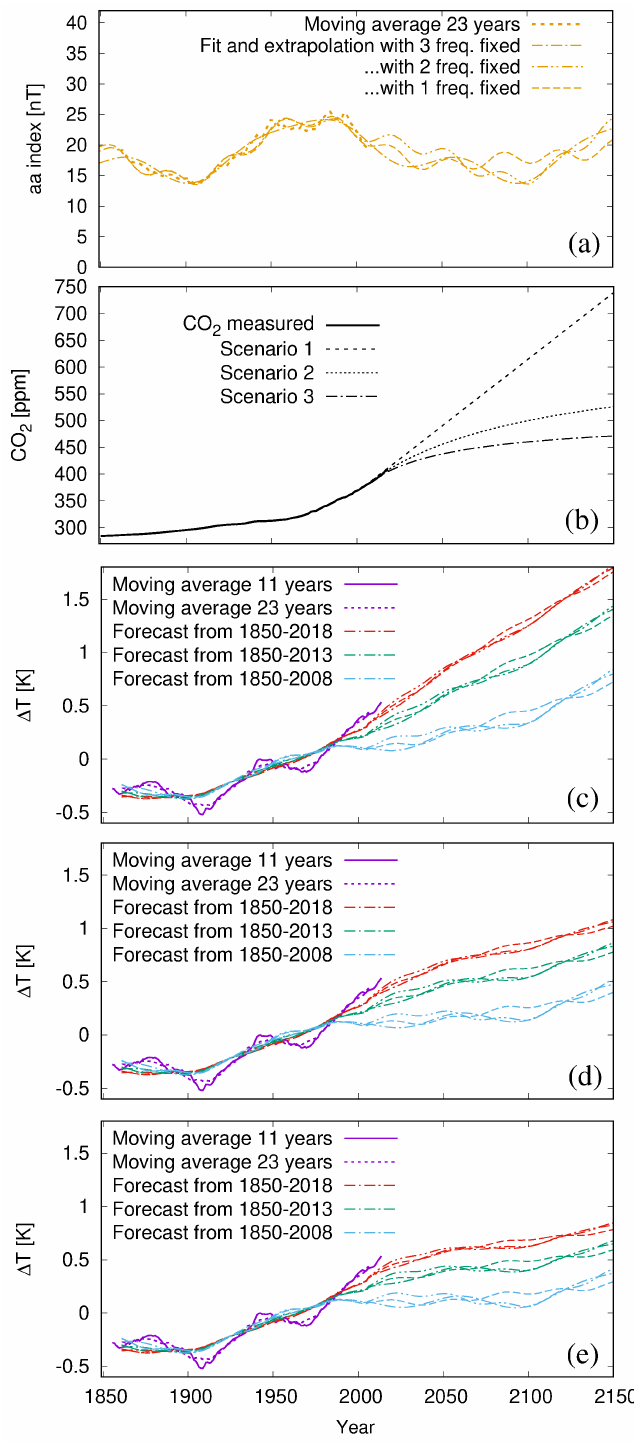
Figure 9. Climate predictions until 2150. ( a ) The 23-year moving average of the aa index, and three 3-frequency fitted to it, extrapolated until 2150. ( b ) Three scenarios for CO 2 concentration. ( c ) Temperature forecasts for the first CO 2 scenario (dashed curve in ( b )), for the three pairs of w aa and w CO resulting from regression with end year 2018 (red), 2013 (green), 2008 (blue). Each of the 2 coloured bundles comprise the three different 3-frequency fits from ( a ). ( d ) Same as ( c ), but for the second CO 2 scenario with a mild decarbonization scheme (dotted line in ( b )). ( e ) Same as ( c ), but for a third CO 2 scenario with a radical decarbonization (dash-dotted line in ( b